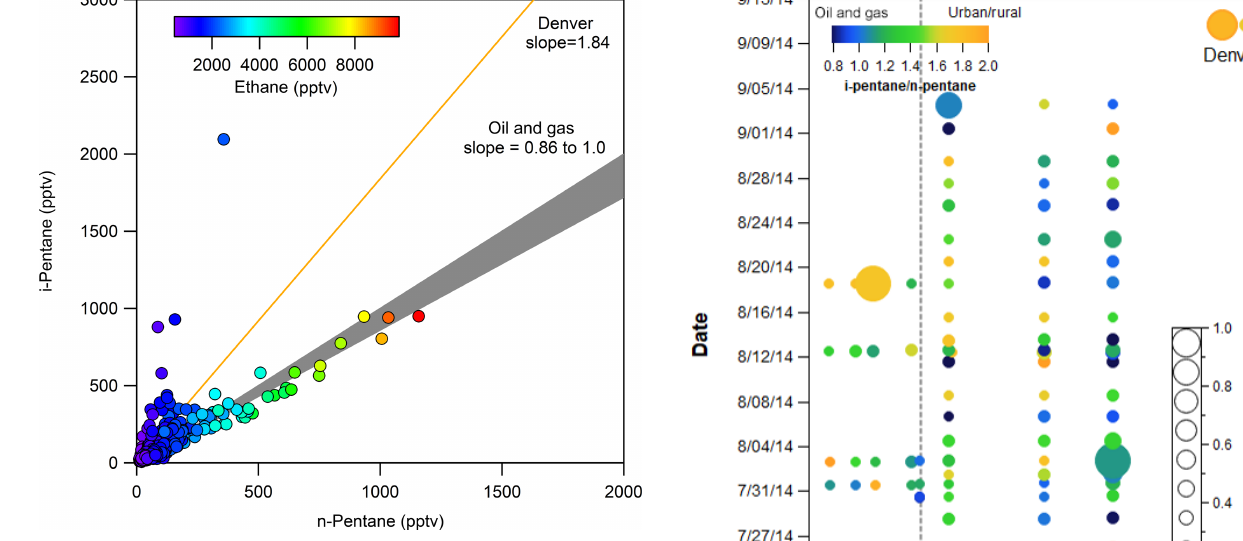
Figure 7. i -Pentane versus n -pentane for ROMO hourly samples, colored by ethane mixing ratio. For reference, also shown are the i - to n -pentane ratios for measurements collected in Denver (Baker et al., 2008) and a range of slopes from 0.86 to 1 line where everything that falls in this range indicates oil and gas influenced (COGCC, 2007; Gilman et al., 2013).